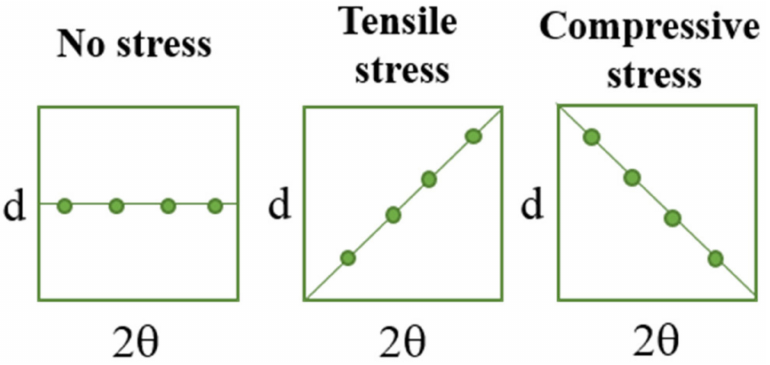
Figure 6. The simplified schemes presenting the changes of d and 2 θ parameters under the tensile load.